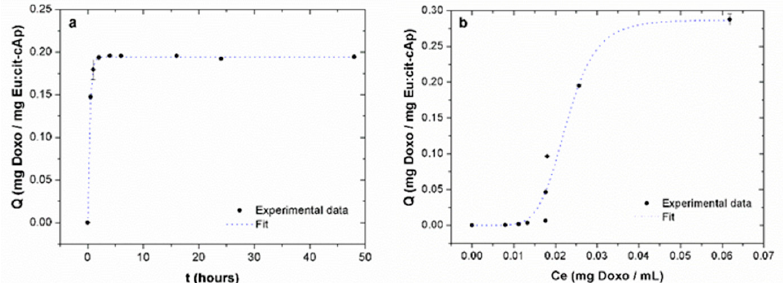
Figure 3. ( a ) adsorption kinetics of Doxo on Eu:cit-cAp nanocrystals. Dotted blue line represents the nonlinear fitting of the experimental data; ( b ) adsorption isotherm of Doxo on Eu:cit-cAp nanocarriers. The dotted blue line represents the nonlinear fitting of experimental data using the Langmuir − Freundlich equation. Table 1. Adsorption parameters calculated from nonlinear fitting of experimental data according to the Langmuir − Freundlich equation.